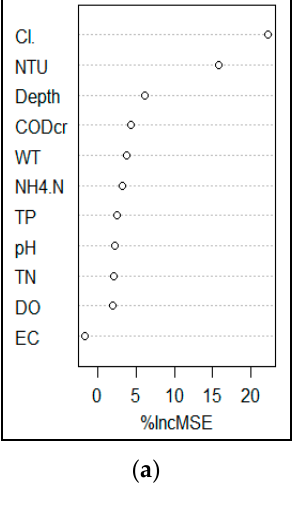
Figure 8. Environmental factors ranked in descending order of importance based on ( a )%IncMSE. and ( b ) major environmental drivers of phytoplankton abundance in summer.